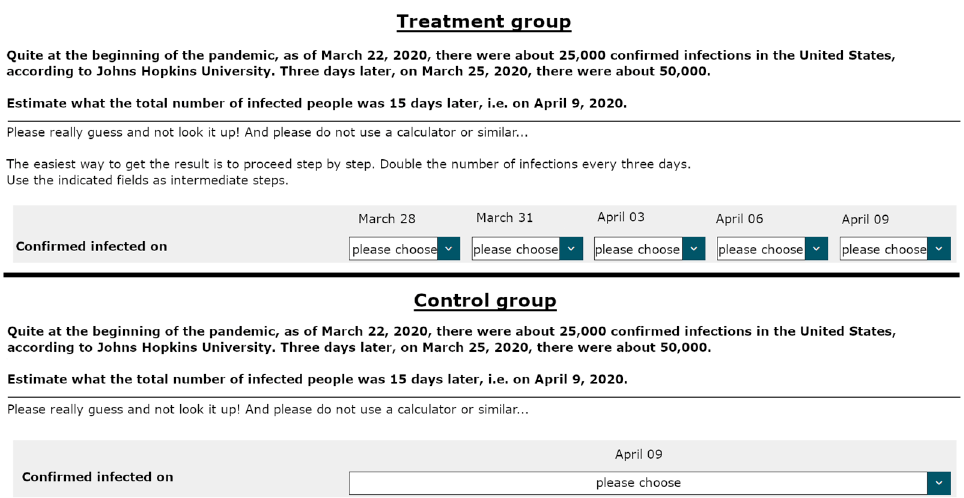
Figure 1. Treatment and control conditions of the experiment (translated from German).